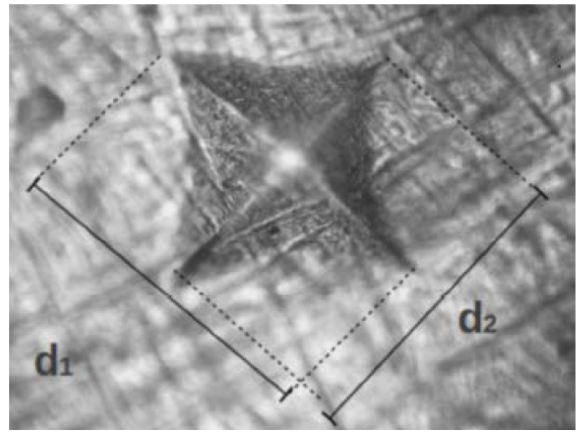
Figure 1. An image of an indentation taken with a CCD camera, with d 1 and d 2 as the measured diagonals of the indentation. They amount to approximately 25 μ m.